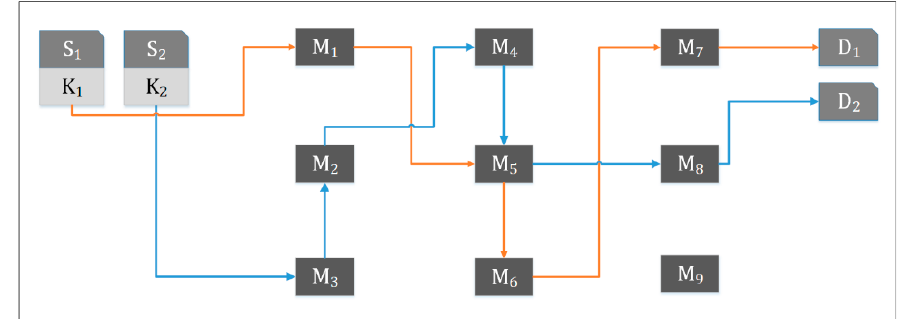
Figure 4. A scenario of two different fabrics being sanforized simultaneously in the environment of 9 finishing machines and taken to the delivery point.